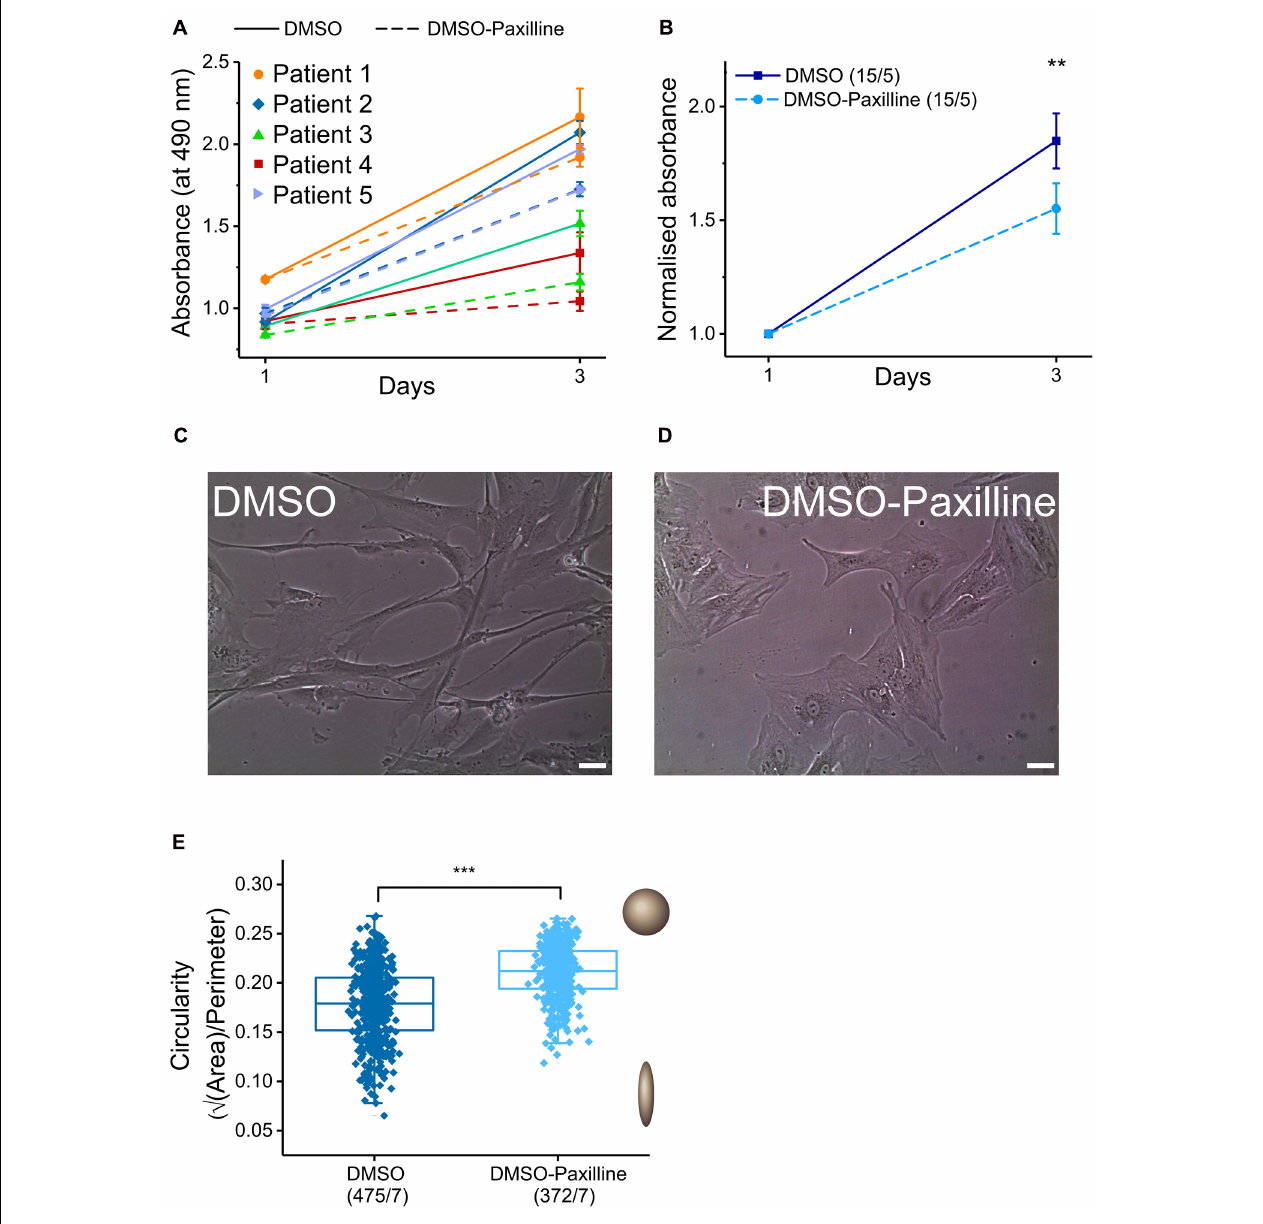
FIGURE 5 | Effects of BK Ca channel blocker paxilline on proliferation rate and cell shape. (A) Proliferation assay in the presence (dashed lines) and absence (continuous lines) of the BK Ca channel blocker paxilline (10 µ mol L − 1 ) after 1 and 3 days in matched samples from five individual SR patients (triplicate measurements for each point). (B) : Mean values for results from the proliferation assay. When normalized to the absorbance value of day 1, the mean increase in absorbance of cells incubated with paxilline was lower (1.6 ± 0.077) than for control conditions (1.8 ± 0.077). (C,D) Representative images of fibroblasts cultured for 2 days with and without paxilline. Scale bar = 20 µ m. (E) Comparison of cell-shape (circularity) of cells incubated with DMSO (control) vs . 10 µ mol L − 1 paxilline in DMSO.